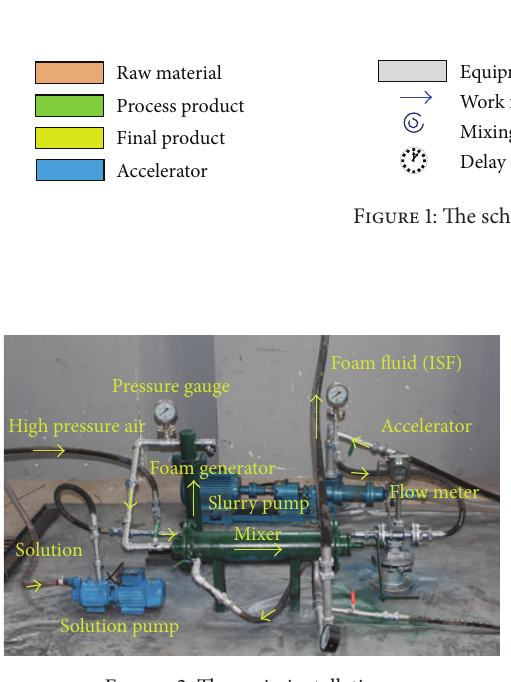
Figure 2: The main